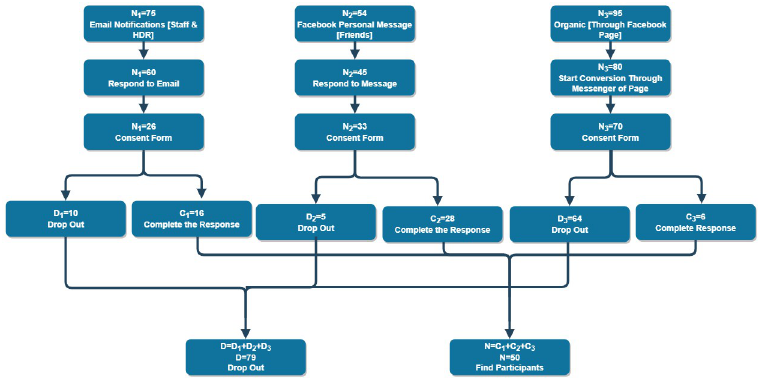
Fig 6. Participant recruitment flow—3 groups indicating statistics of complete response and dropout